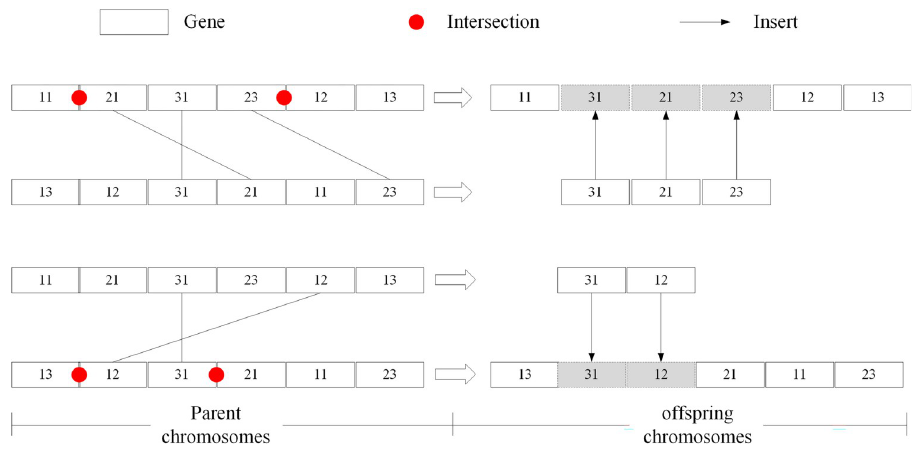
Fig 9. Interlace operation process of chromosome.